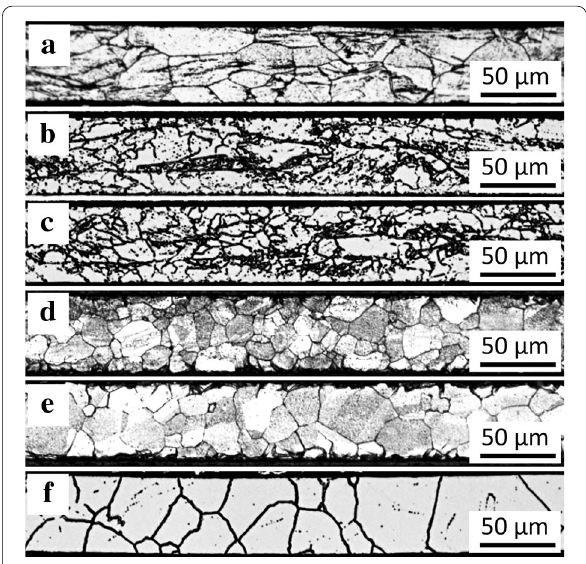
Figure 3 Microstructure of the annealed specimens: a A700, b A850, c A900, d A950, e A1000, f A1100